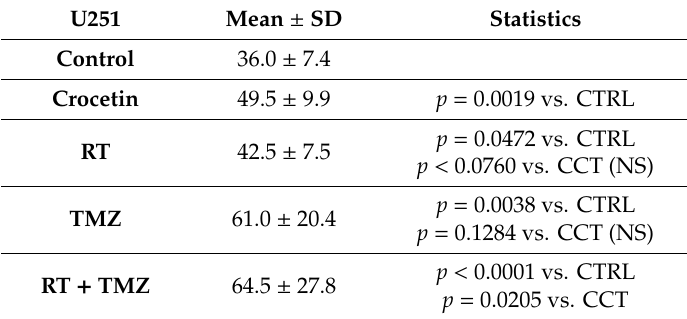
Table 4. Summarized statistical data of bioluminescence appearance times, as analyzed in Figure